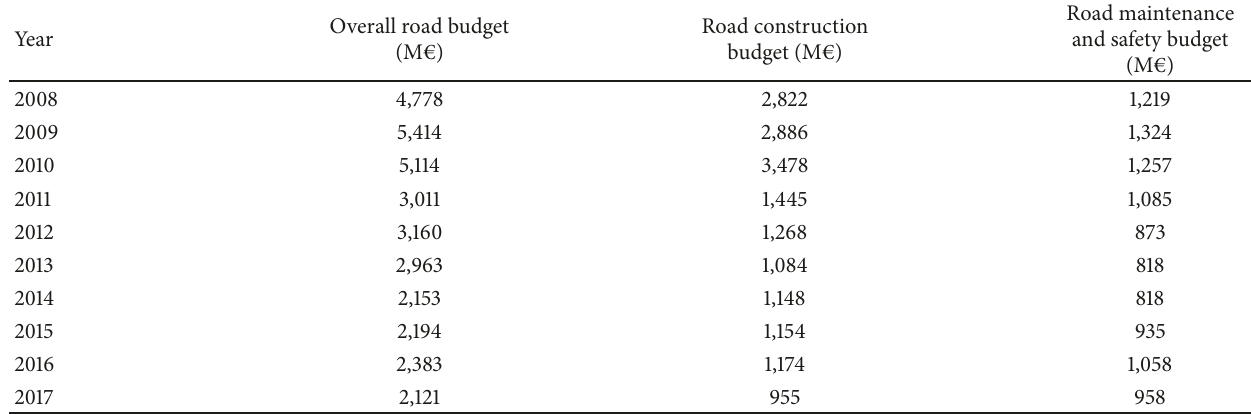
Table 1: Evolution of investment in roads